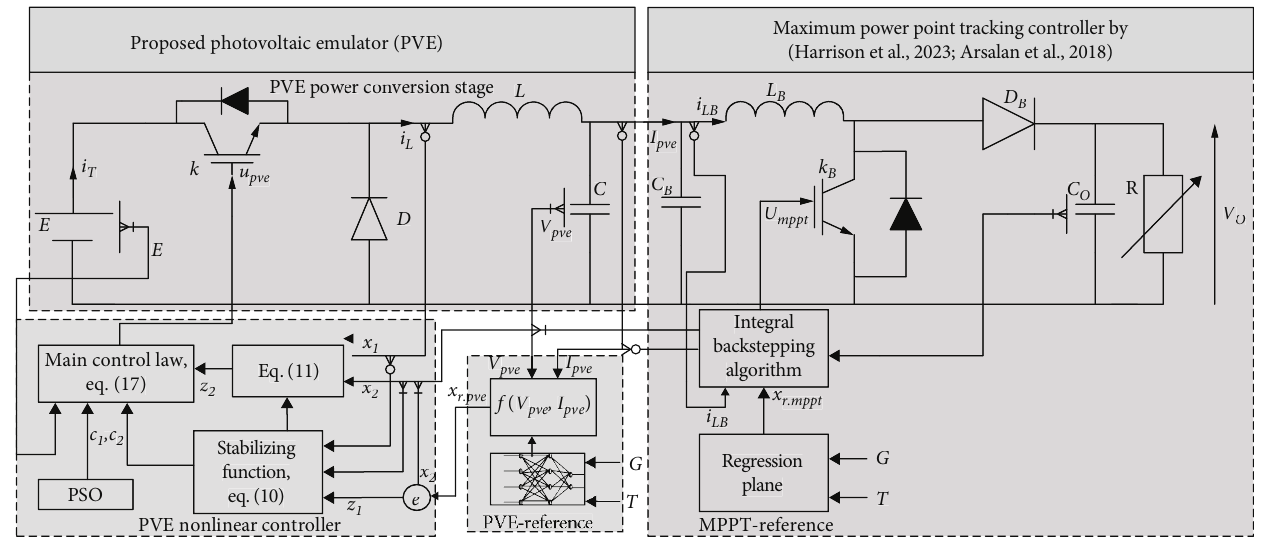
Figure 8: Architecture of the proposed PVE coupled with an MPPT controller (MPPT stage from [33,